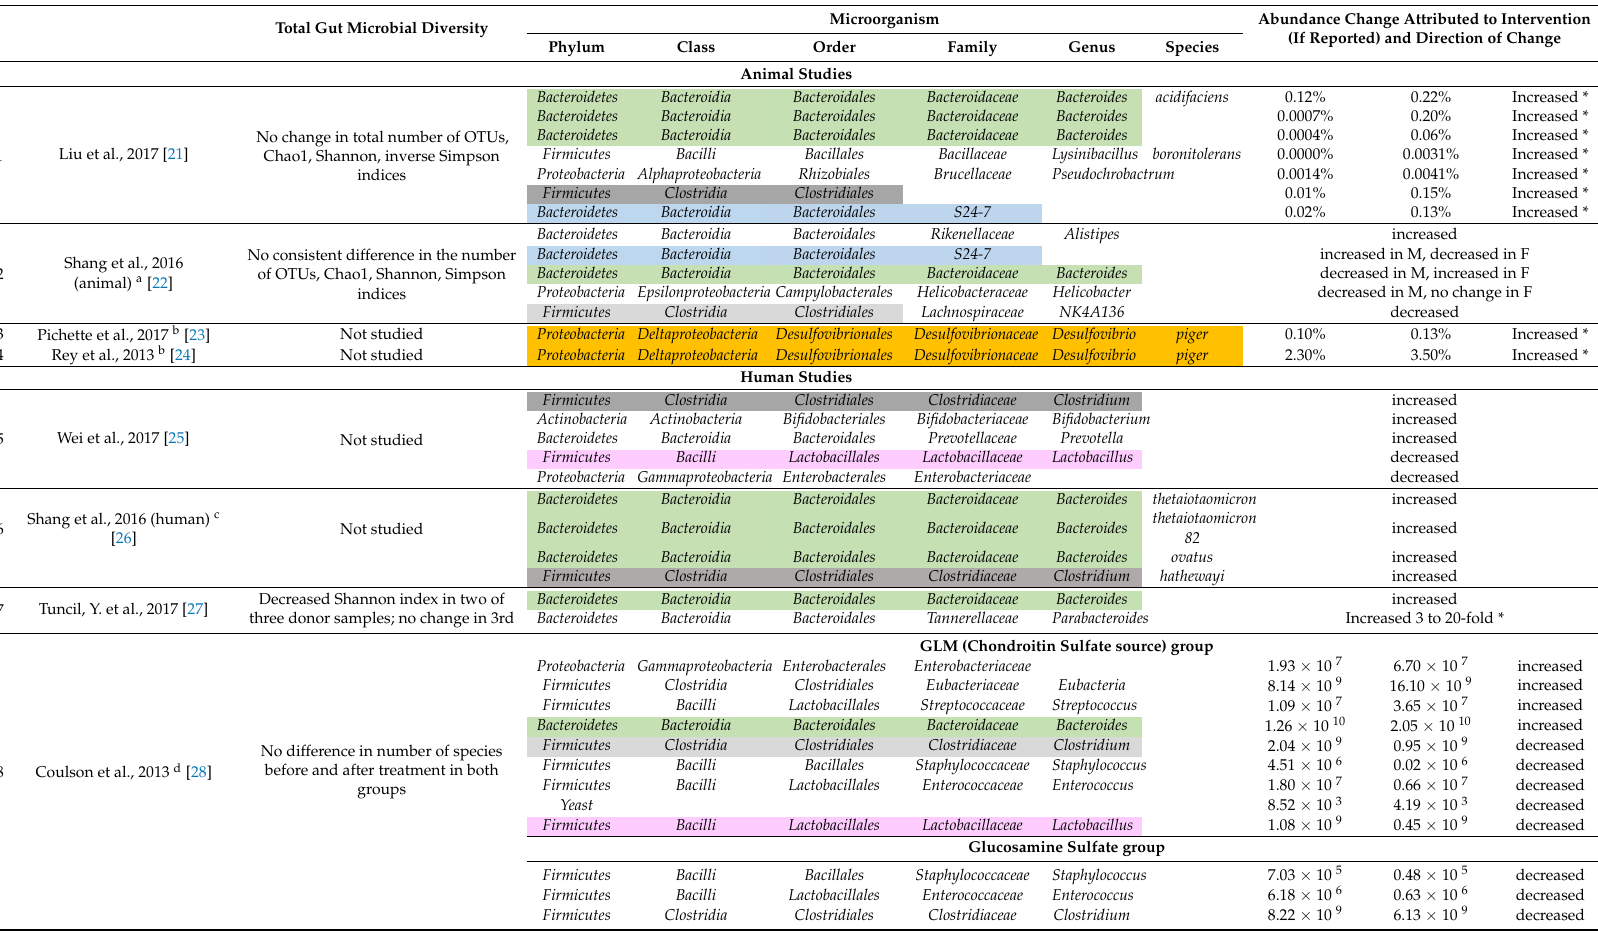
Table 2. Key results: The associations of chondroitin and glucosamine sulfate exposure with gut microbial diversity and abundance of specific